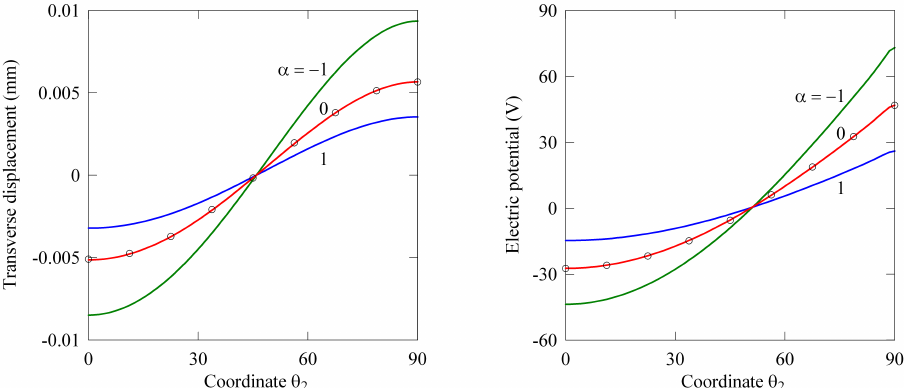
Figure 13: Distribution of the transverse displacement of the bottom surface u 3 (0, θ 2 , −0.5) and the electric potential of the surface lo- cated close to the middle surface ϕ (0, θ 2 , −0.0555) in section AB for a thick cylindrical shell along coordinate θ 2 ; GeXSaS4 element (—) using nine SaS and isoparametric layer-wise shell element [50] for α = 0 ( ∘